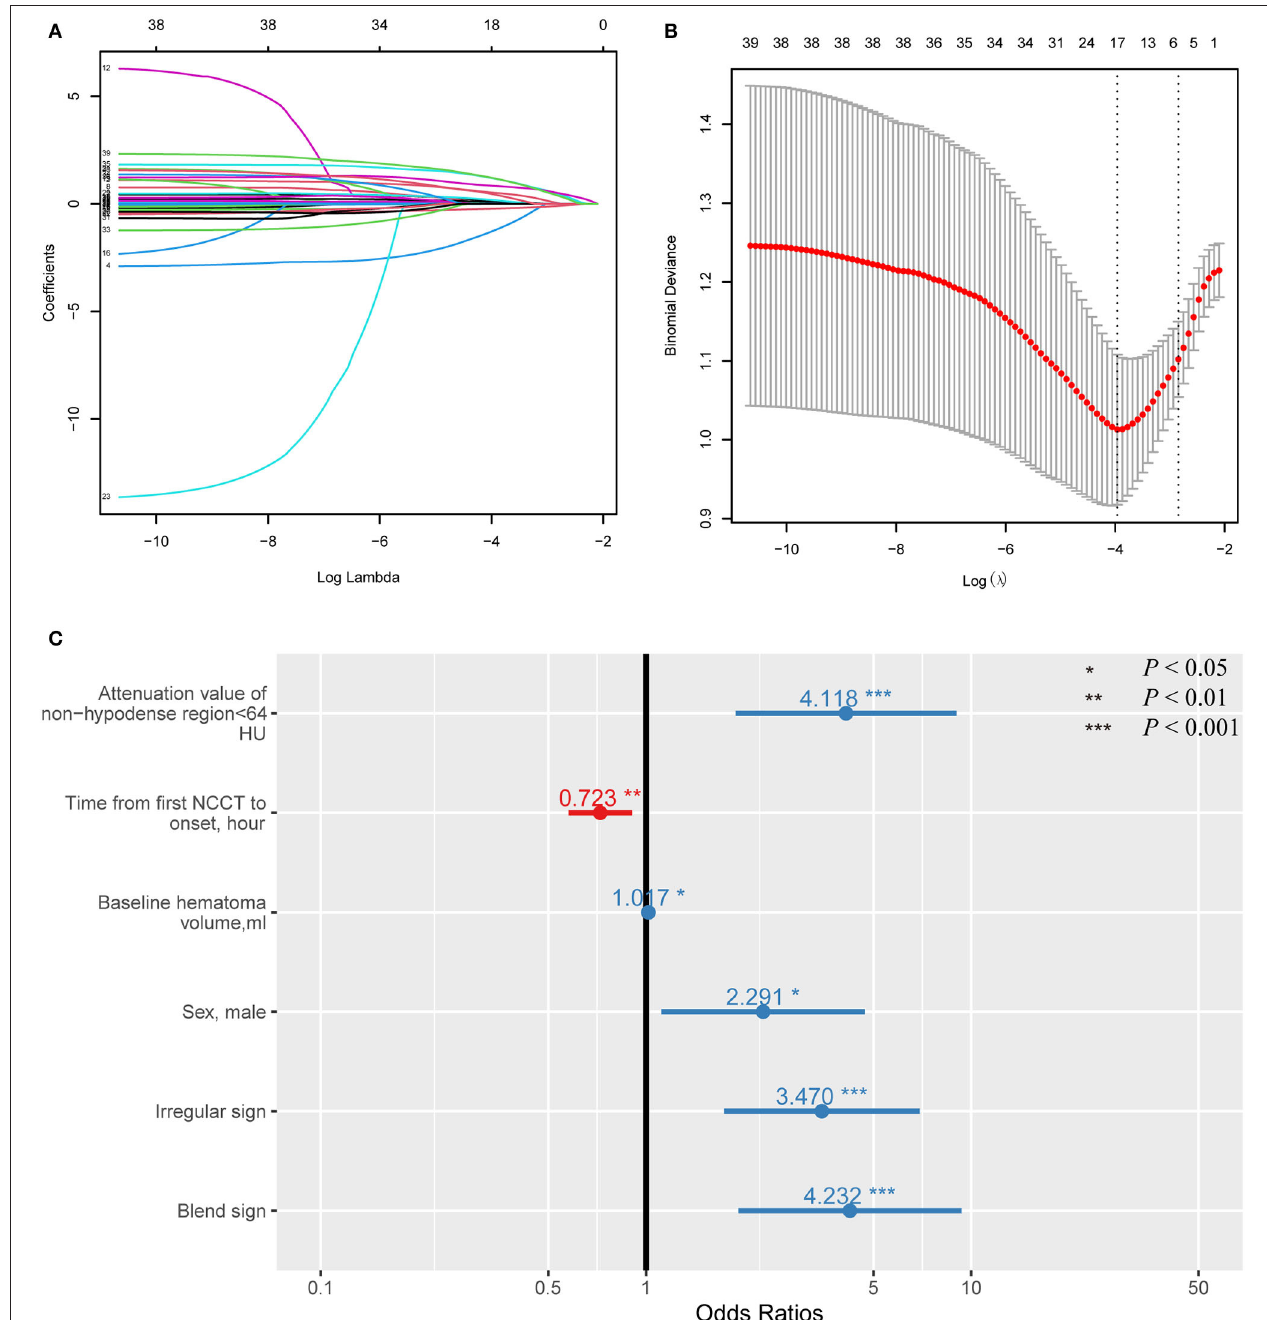
FIGURE 6 | Forest plot showing the results of multivariate analysis. The potential predictors included in the multivariate analysis were first screened by the least absolute shrinkage and selection operator (LASSO) regression. (A) LASSO coefficient curves for 39 variables, such as age, sex, time of onset, radiological characteristics of the hematoma, medical history, physical examination, and laboratory parameters. (B) Dotted vertical lines were drawn at the optimal values by using the minimum criteria and the one-standard error of the minimum criteria (the 1-SE criteria). Six variables with non-zero coefficients (attenuation value of non-hypodense region < 64 HU, time from the first NCCT scan to onset, baseline hematoma volume, sex, irregular sign, blend sign) were identified. (C) Forest plot of all six variables identified by LASSO regression that have p < 0.05.